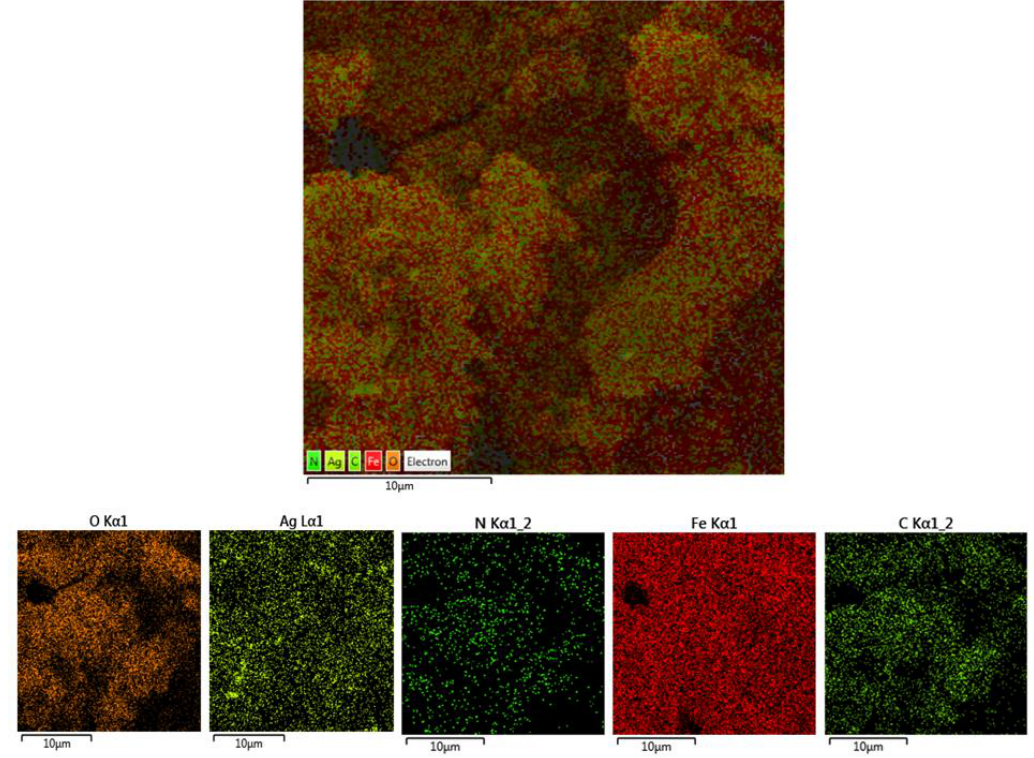
Figure 6. Energy dispersive X-ray (EDX) mapping of the catalyst Fe 3 O 4 @CS@MS@Ag after fifth catalytic cycle of the catalytic reaction.